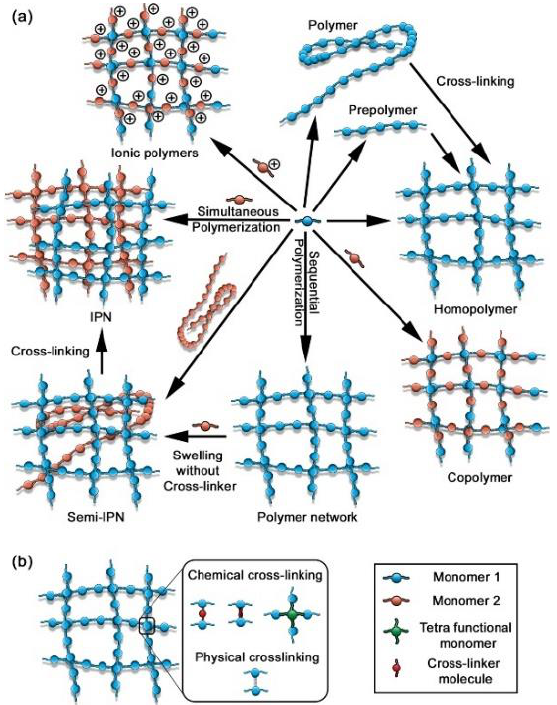
Figure 3. ( a ) Representation of various categories of hydrogels. ( b ) Preparation by cross-linking between polymer chains [63].